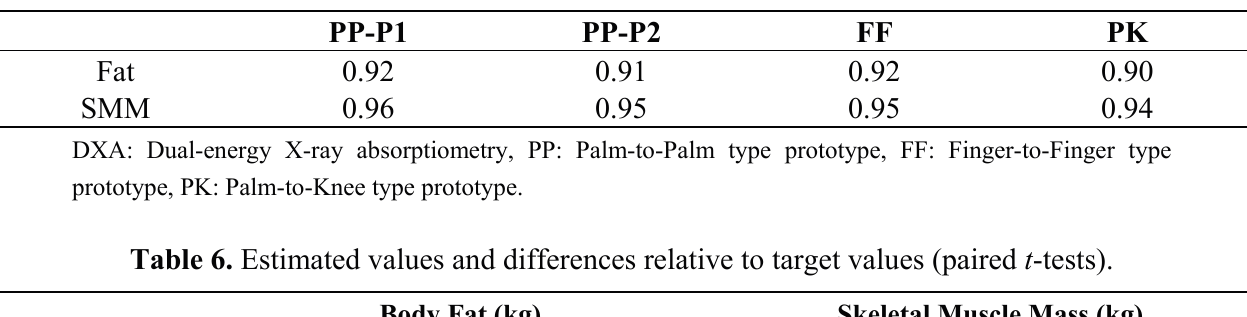
Table 5. Correlation coefficients between the estimated and DXA results.